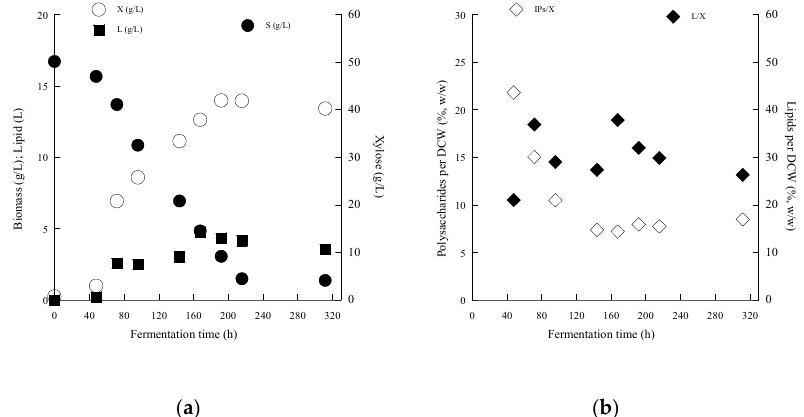
Figure 1. Kinetics of ( a ) biomass (X, g/L) and lipid (L) production as well as xylose consumption and ( b ) polysaccharides in DCW (% w / w ) and lipids in DCW (% w / w ) during shake-flask fermentations of R. toruloides DSM 4444 when 20 g/L of lignosulphonates (LS) were applied in shake-flask nitrogen-limited media. The culture conditions were: 250 mL Erlenmeyer flasks filled up to 50 mL at 180 rpm, initial pH = 6.0, pH ranging between 5.2 and 5.8, incubation temperature T = 28 °C, initial sugar concentration ca. 50 g/L. Each experimental point is the mean value of two independent measurements.